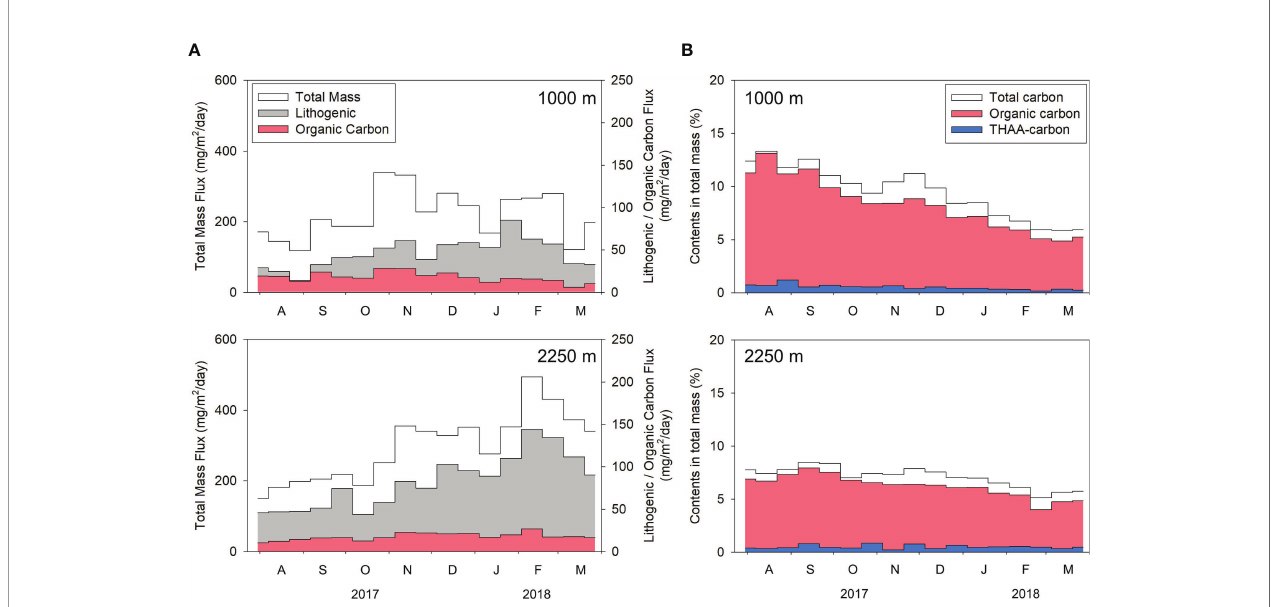
FIGURE 3 | Total mass fl ux, lithogenic fl ux, organic carbon fl ux (A) , and percentages of total, organic, and THAA carbon (B) for sinking particle collected at depths of 1000 m and 2250